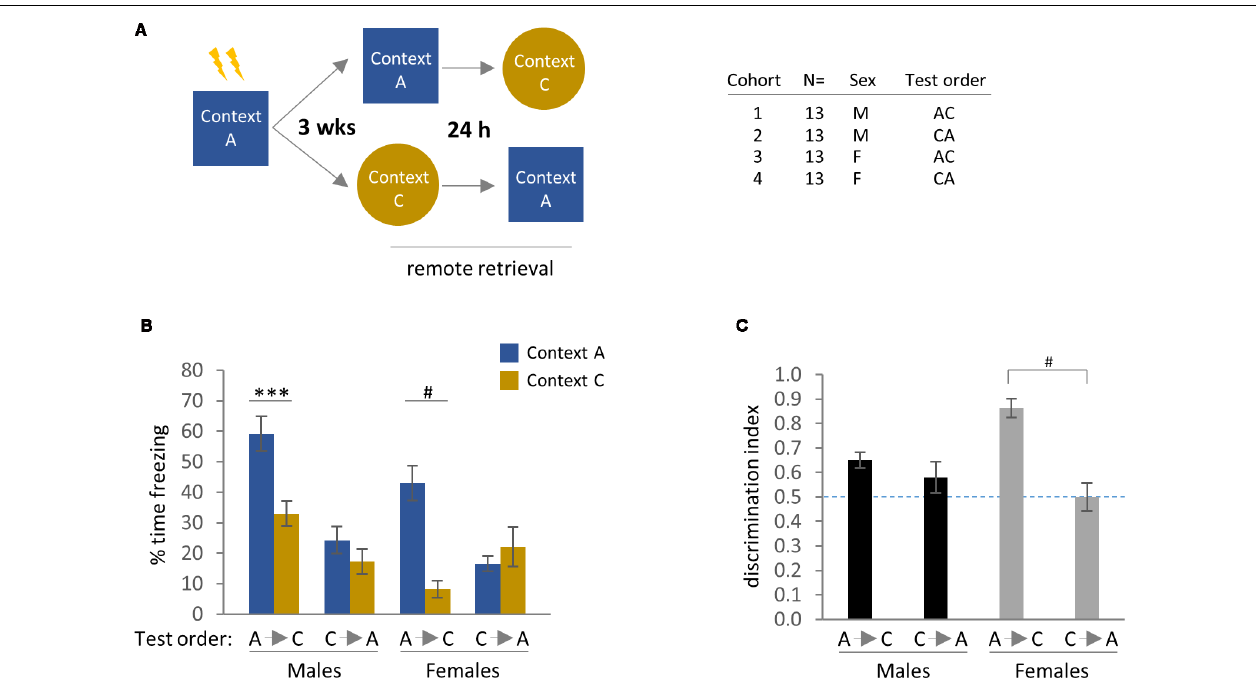
FIGURE 6 | Remote contextual fear generalization using context that retains metal grid floor used in the training context. (A) Experimental design. Context A and Context C are completely different in terms of odor, chamber shape, and lighting. However, the same metal grid floor through which shocks were delivered during training is present in both contexts. (B) Freezing behavior of male and female mice in remote contextual generalization, with both test orders (A → C and C → A). Significant Bonferroni post hoc effects following three-way ANOVA are indicated. (C) Discrimination index calculated from freezing data, with Bonferroni post hoc test following two-way ANOVA revealed a significant effect of test order in females. ∗∗∗ p < 0.001 and # p < 0.0001. Error bars are mean ±